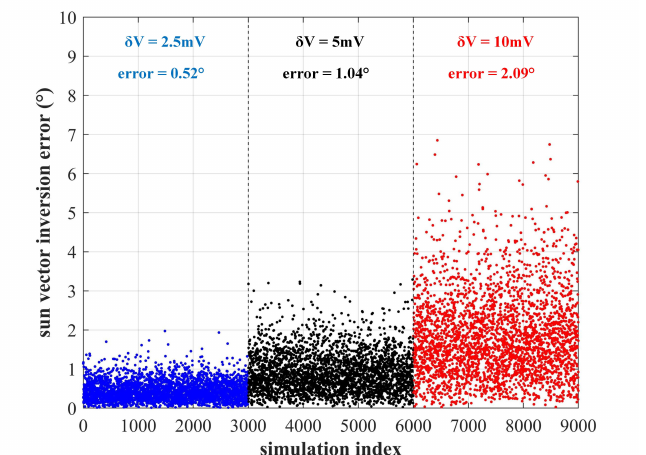
Figure 6. The sun vector inversion accuracy considering voltage sampling error of various